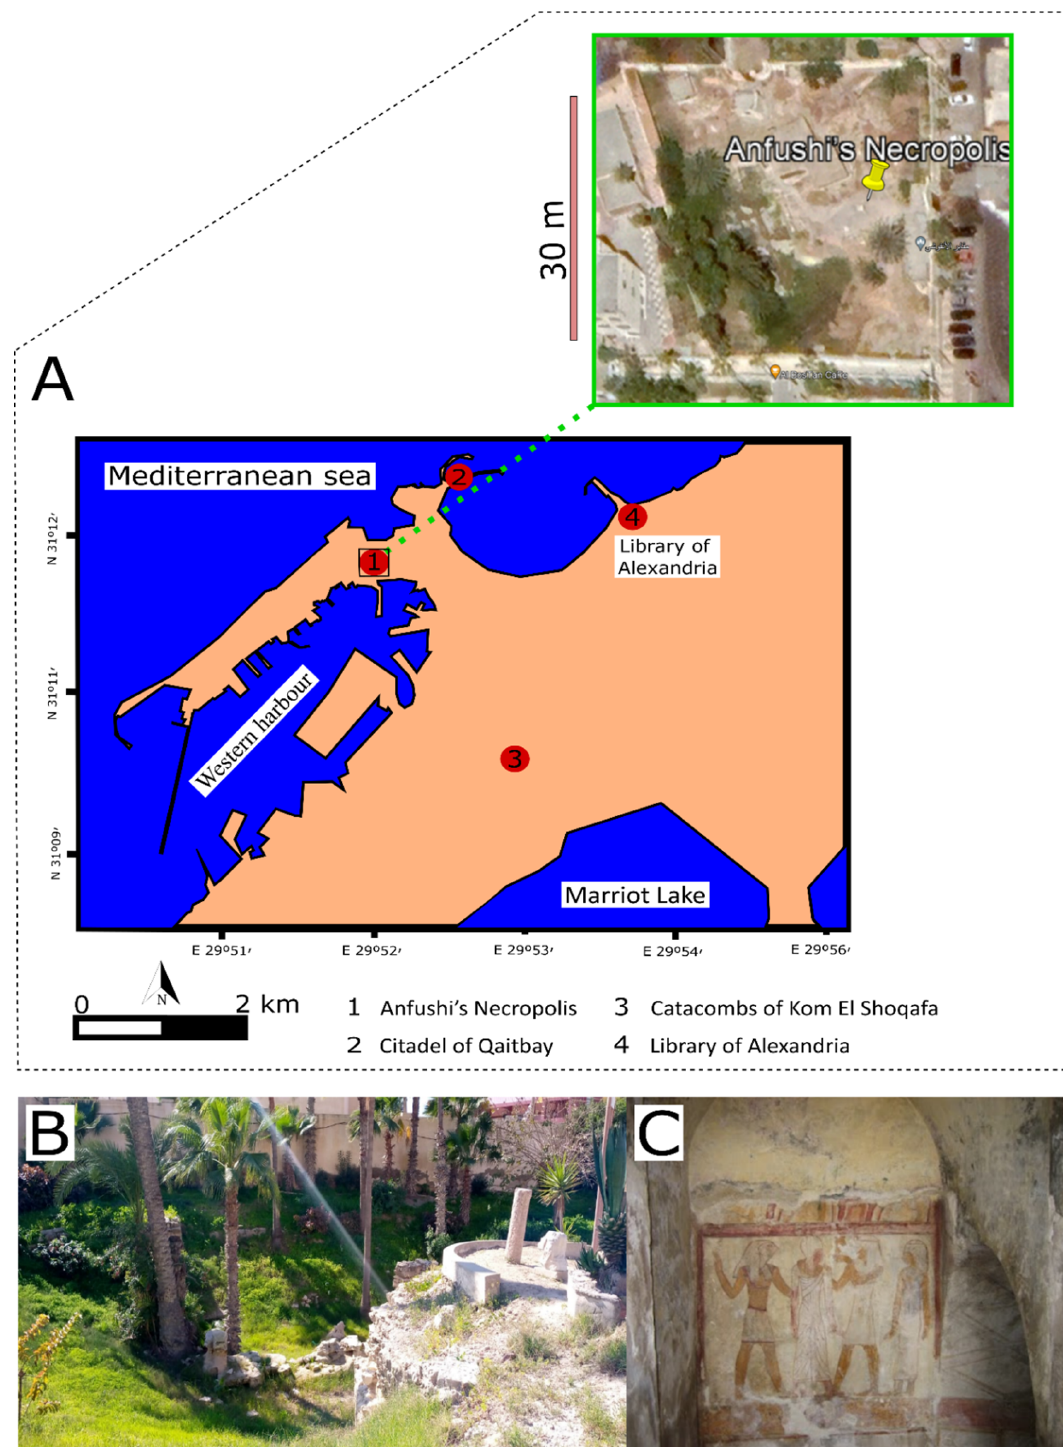
Figure 1. ( A ) The geographical location of Anfushi’s Necropolis on the coast of the Mediterranean Sea. ( B ) The general view and the current state of preservation of Anfushi’s Necropolis. ( C ) Ancient Egyptian-style scene.